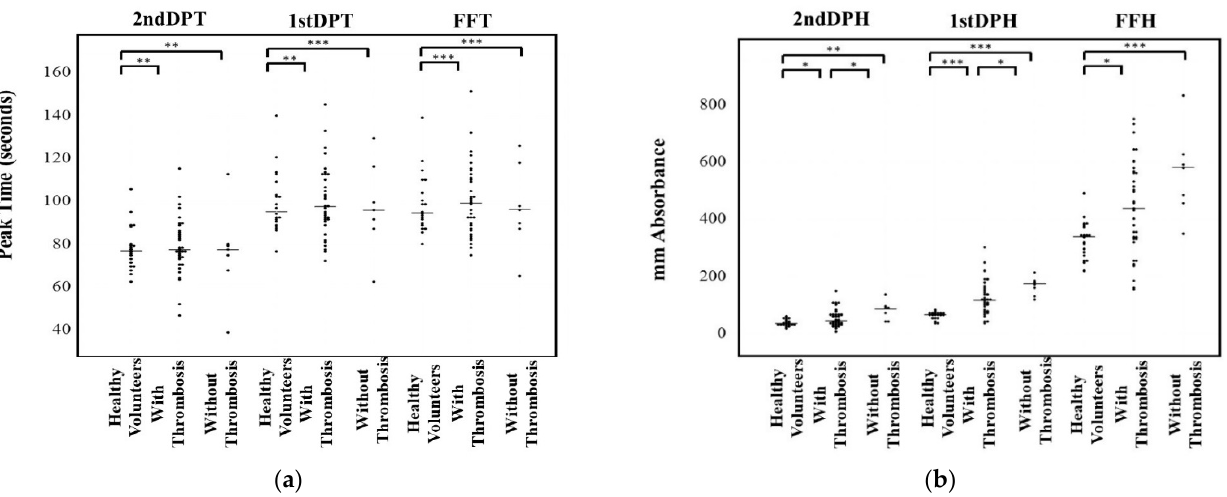
Figure 2. Peak time ( a ) and height ( b ) of activated partial thromboplastin time. DPT, derivative peak time; FFT, fibrin formation time; DPH, derivative peak height; FFH, fibrin formation height; *, p < 0.05; **, p < 0.01; ***, p < 0.001.